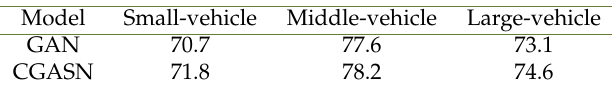
Table 2. Comparison of